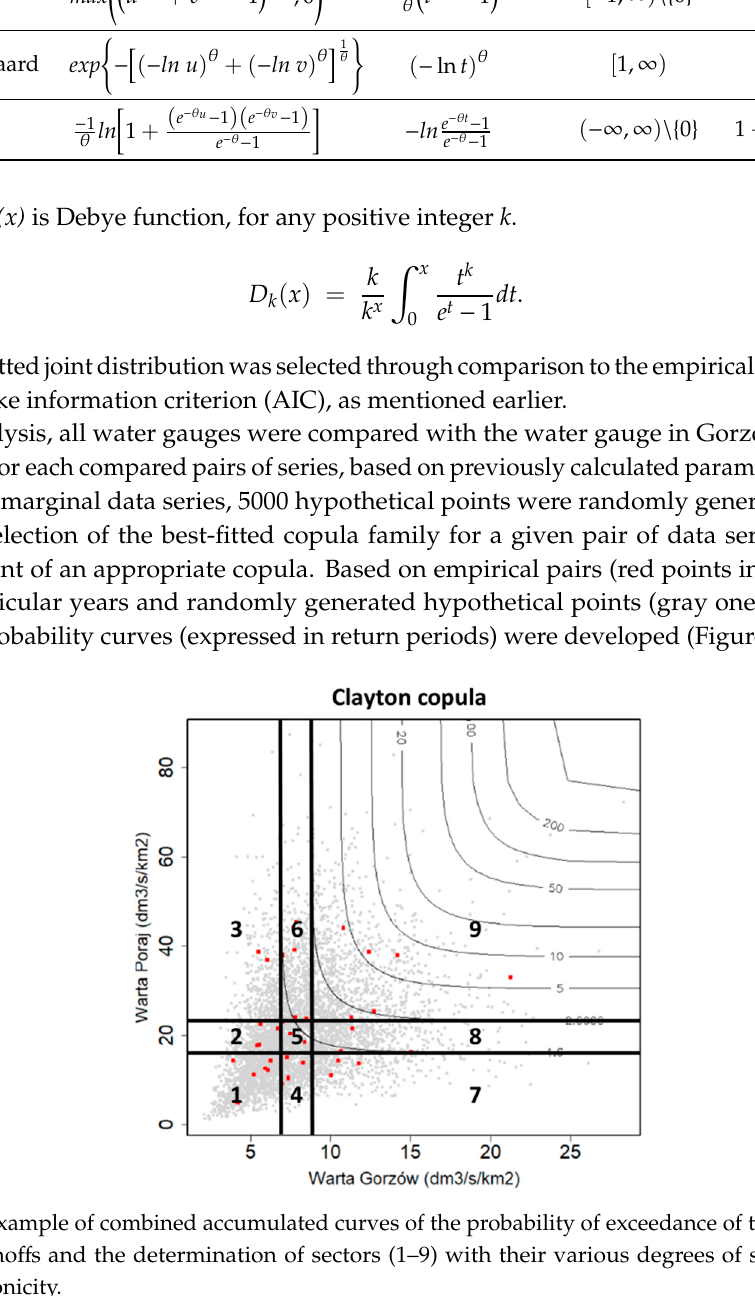
Table 2. Copula function, parameter space, generating function Φ ( t ), and functional relationship of Kendall’s τ θ with a copula parameter for selected single-parameter bivariate Archimedean copulas. Copula Family C θ ( u , v ) Parameter θ ∈ Copula